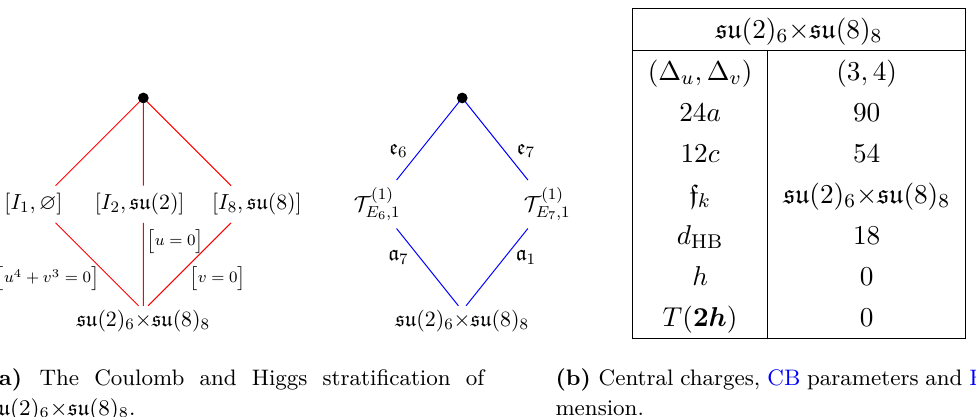
Figure 6. Information about the su (2) 6 × su (8) 8